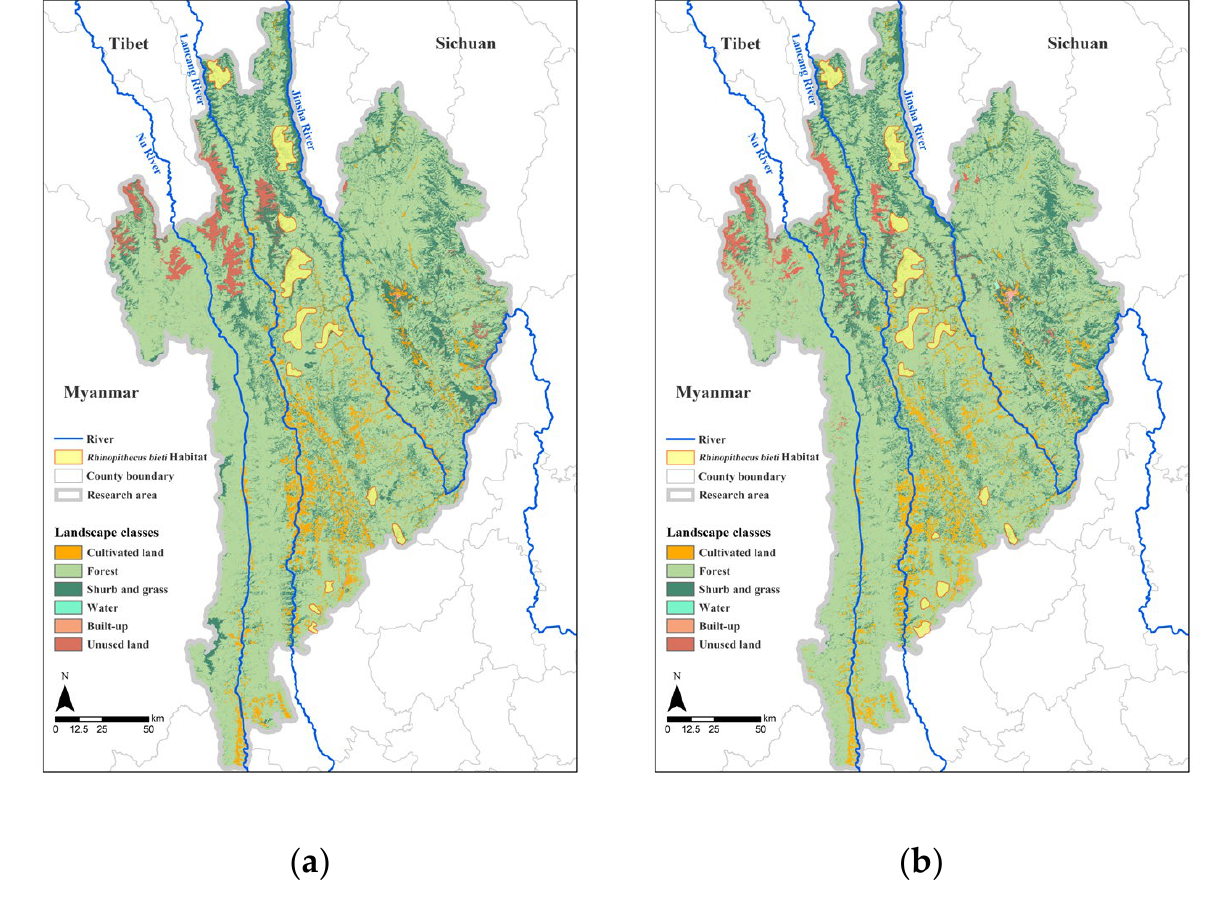
Figure 4. Landscape classes of the Three Parallel Rivers Natural World Heritage Site in 2000( a ) and 2020( b ). The boundaries of Rhinopithecus bieti habitat in 2000 and 2020 are drawn with reference to the p opulation map of the Yunnan snub-nosed monkey released by The Nature Conservancy (https://www.tnc.org.cn/ (accessed on 10 May 2022))